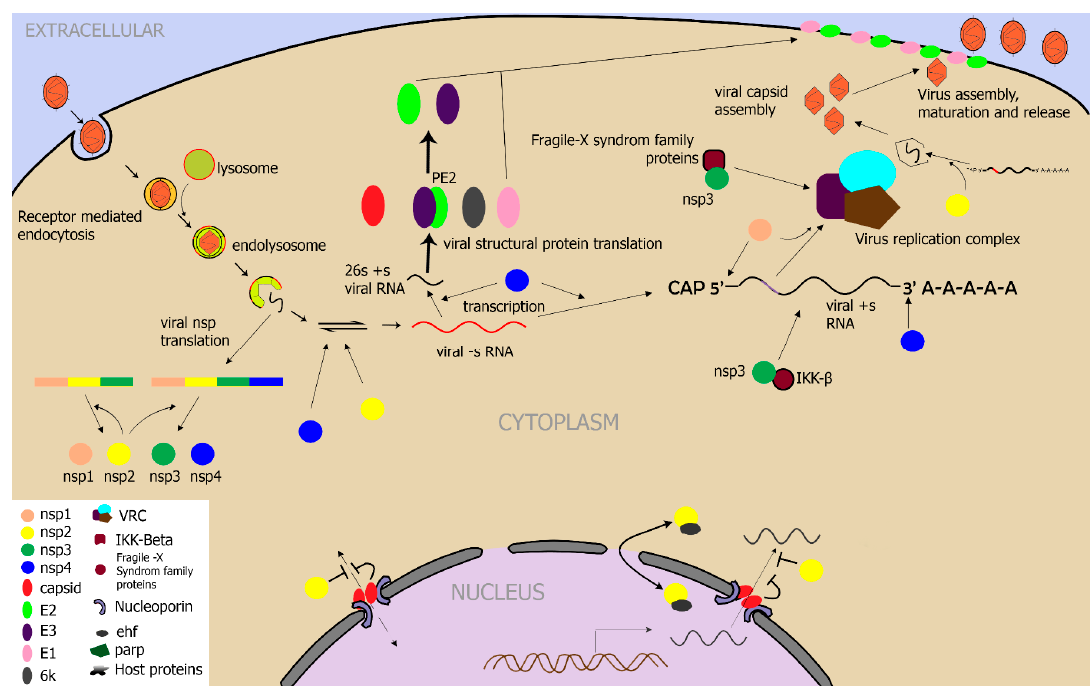
Figure 4. Replication of VEEV in host cell . VEEV enters in the host cells by receptor mediated binding of the virus to the host cell membrane. Virus containing endosomes fuse with lysosomes resulting in formation of endolysosomes. Viral RNA is released in the cytoplasm following pH dependent conformational changes in the viral proteins, allowing fusion with the endolysosome membrane. VEEV is a single-stranded positive-sense RNA virus that replicates in the cytoplasm and does not have a nuclear phase of replication. In the second phase of infection, viral nsp are translated as P123 and P1234 polyproteins from the viral genomic RNA. Autolytic activity of nsp-2 cleaves the viral polyproteins in individual nsp-1, nsp-2, nsp-3, and nsp-4 proteins. Nsp-4 is a viral RdRp, which with methyltransferase activity of nsp-2, drives synthesis of negative-sense viral RNA. Negative-sense viral RNA is transcribed into smaller 26S subgenomic positive-sense RNA and a full-length positive-sense viral RNA. Subgenomic 26S RNA is translated into viral structural proteins namely capsid, a polyprotein of E3 and E2 called PE2, 6k, and E1. PE2 is processed into E3 and E2 proteins by cutting at the furin-cleavage site in PE2. Viral nsp-2 plays a role in capping of viral genomic RNA via its methyltransferase and guanylylation activity. Nsp-4 adds a poly-A tail to the viral genomic RNA via its terminal adenyltransferase activity. Full length positive- sense viral RNA is incorporated into a virus replication complex (VRC). Assembly of VRC is aided by interaction of viral non-structural proteins with host proteins such as nsp-3 with IKK- β and Fragile- X syndrome family proteins. Nsp-3 binds to other unknown host proteins during formation of VRC, the role of which is not yet understood. Nsp-1 conserved sequence element helps in the recognition of the core promoter element of the virus genome by VRC. In addition to direct involvement of viral proteins in replication and assembly, viral non-structural proteins interact with host factors to promote VEEV replication. Capsid proteins bind to components of the nuclear pore complex effectively blocking nuclear-cytoplasm-nuclear traffic and host protein translation. Nsp-2 interacts with karyopherin-alpha 1 for its nuclear localization function, role of which is not clearly understood. Nsp2 plays a role in loading of the viral RNA into nucleocapsid and maturation of virions. In the final step structural proteins E1 and E2 are embedded in the plasma membrane, and assembly and release of the mature virion particle occurs by encapsulating nucleocapsid and budding at plasma membrane